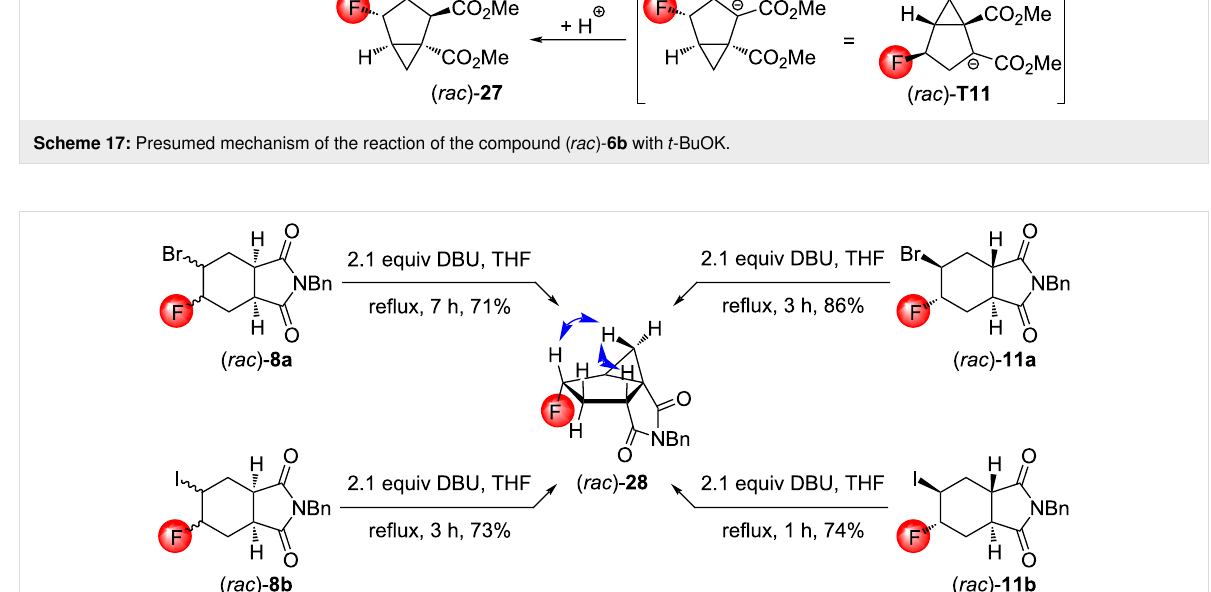
Scheme 18: Cyclizations of halofluorinated tetrahydrophthalimides with DBU. Relevant NOESY interactions are marked with two-headed